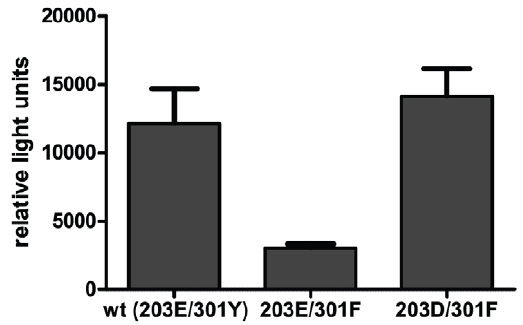
Figure 3. The effect of changes in the most significant co- evolving pair on virus infectivity. The reduction in infectivity caused by the single mutation is rescued by the compensatory mutation in the co-evolving